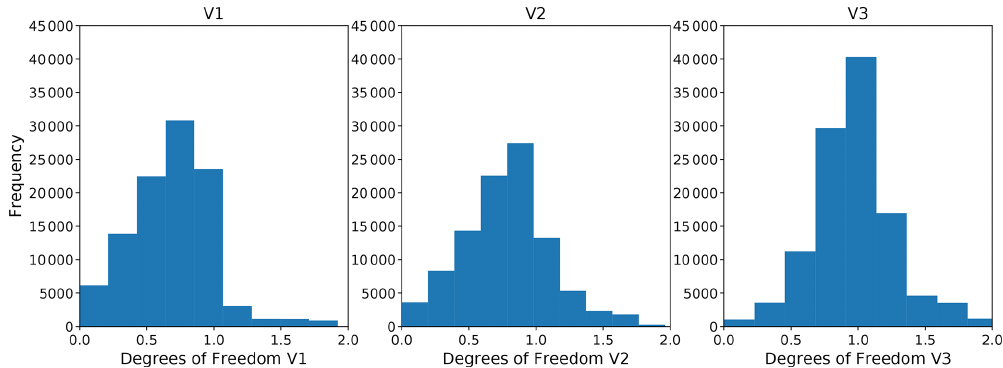
Figure 8. Histograms showing degrees of freedom and frequencies for V1, V2 and V3 retrievals.